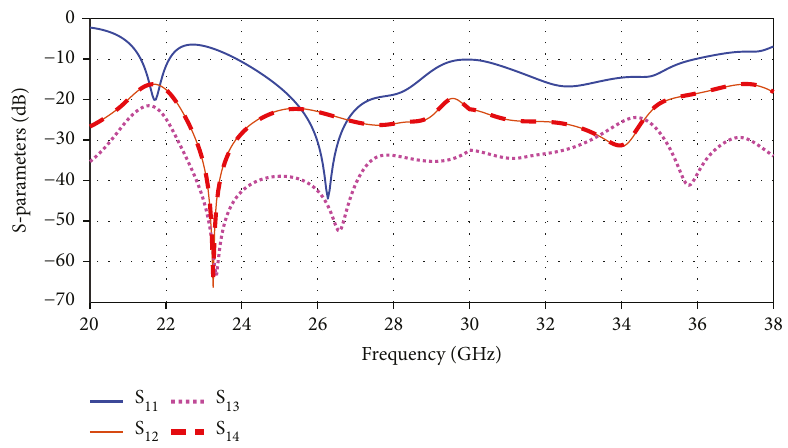
Figure 9: Measured S-parameters of the fabricated MIMO